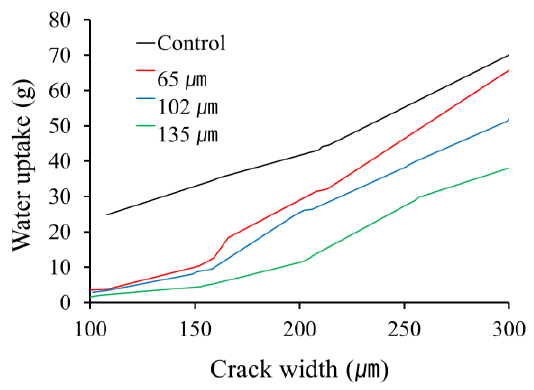
Figure 5. Water uptake versus crack width of the control and self-healing coatings containing microcapsules with mean diameter of 65, 102 or 135 µm. Capsule-loading of the self-healing coating was 20 wt% and undercoating thickness was 50 µm.